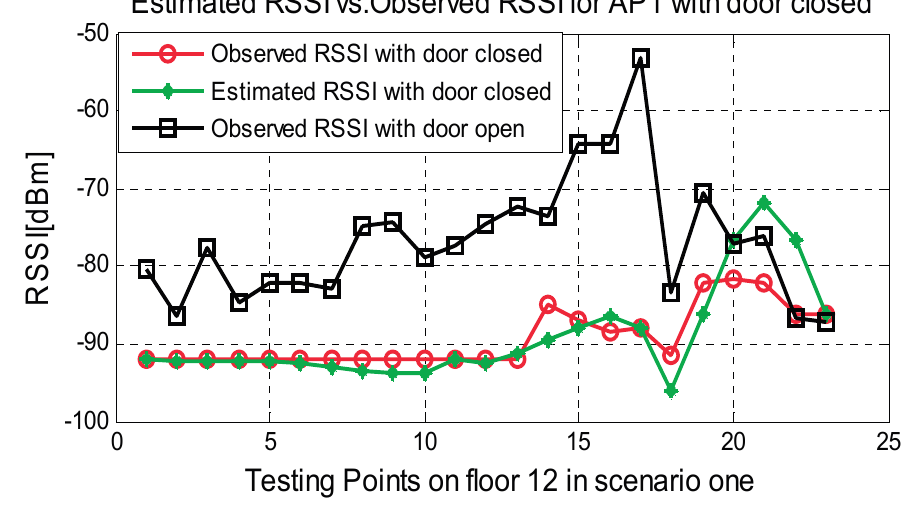
Figure 8. Estimated RSSI for AP1 with door